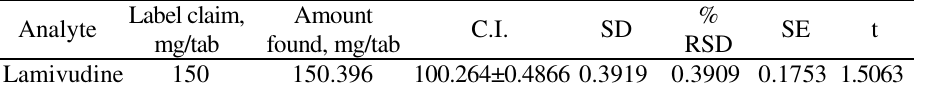
Table 2. Analysis of marketed formulation.